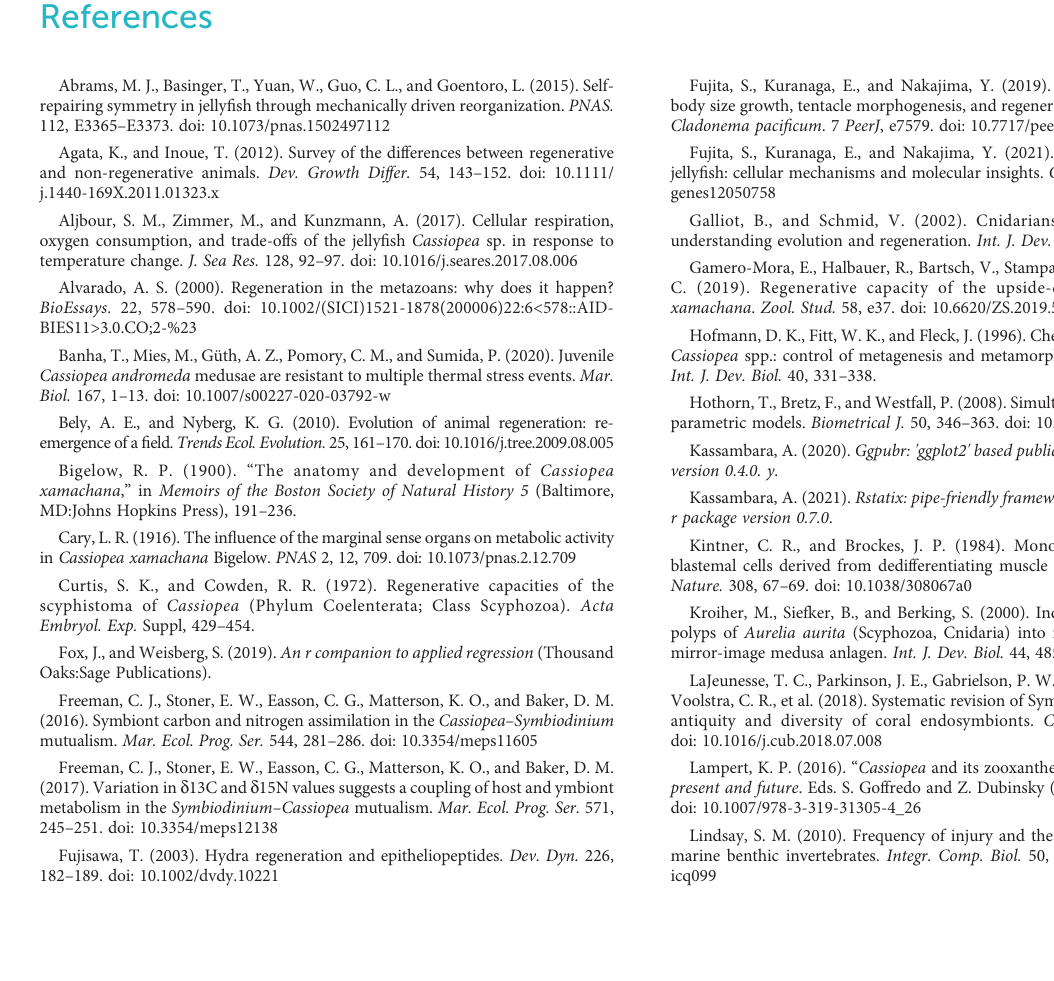
SUPPLEMENTARY TABLE 1 Calculation Regeneration Class.